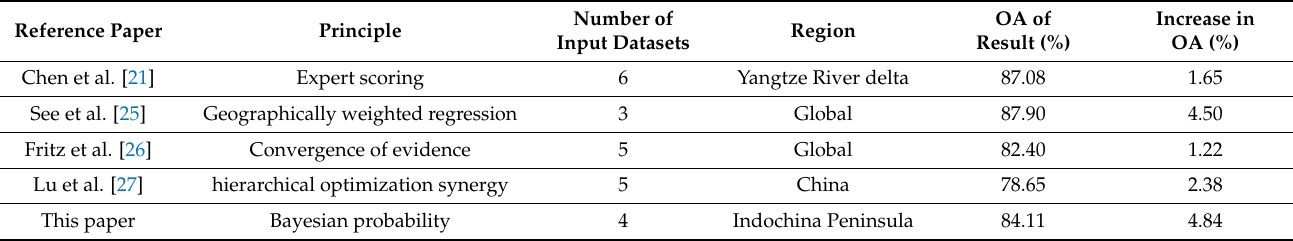
Table 4. Overall accuracy (OA) compared with other